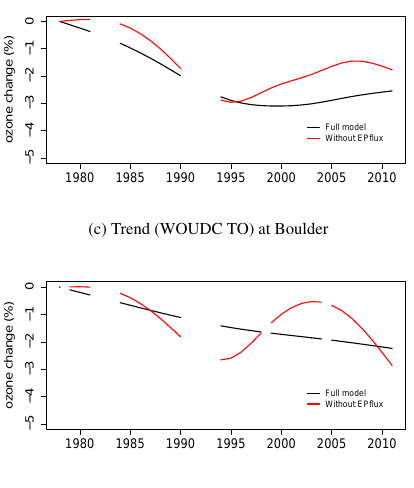
Fig. 18. Estimated trends for total column ozone at Arosa. (a): ozone trends for Umkehr (in red solid line) and WOUDC (in black solid line) TO with their 95% confidence intervals in dotted lines with the matching colour. (b): ozone trends for WOUDC TO ob- tainedfromthefullregressionmodel(inblack)andthemodelwith- outEPflux(inred). (c): ozonetrendsforUmkehrTOobtainedfrom the full regression model (in black) and the model without EP flux (in red). Fig. 17. Estimated trends for total column ozone at Boulder. (a)